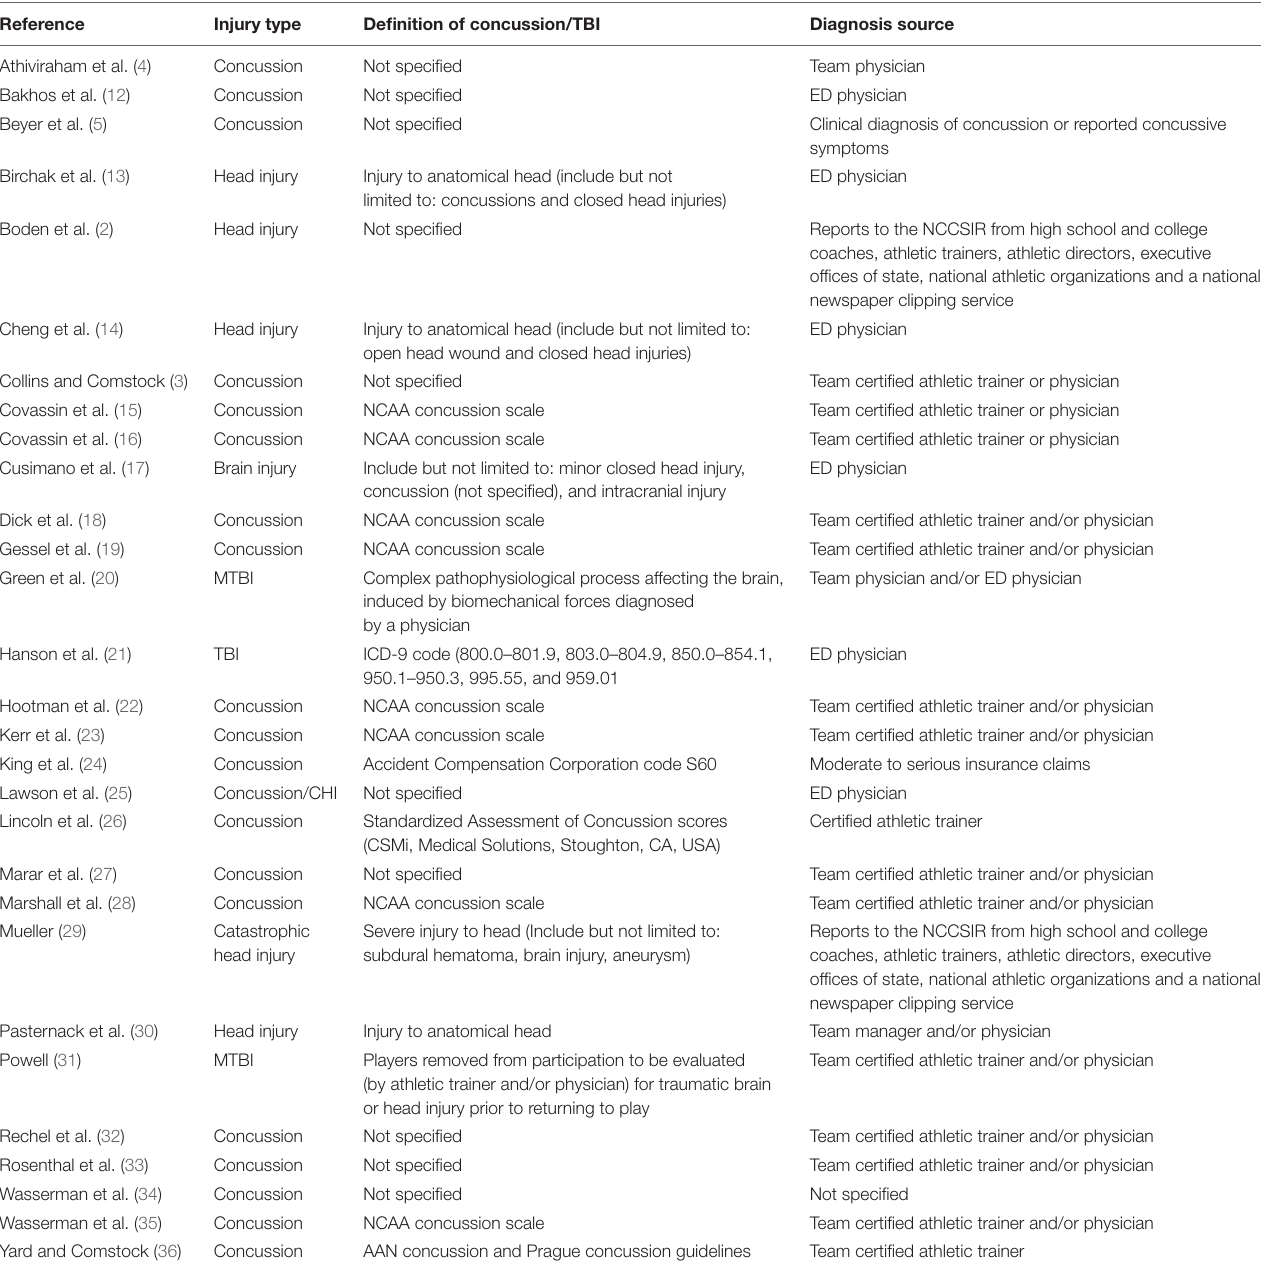
taBLe 3 | Definition and diagnosis of